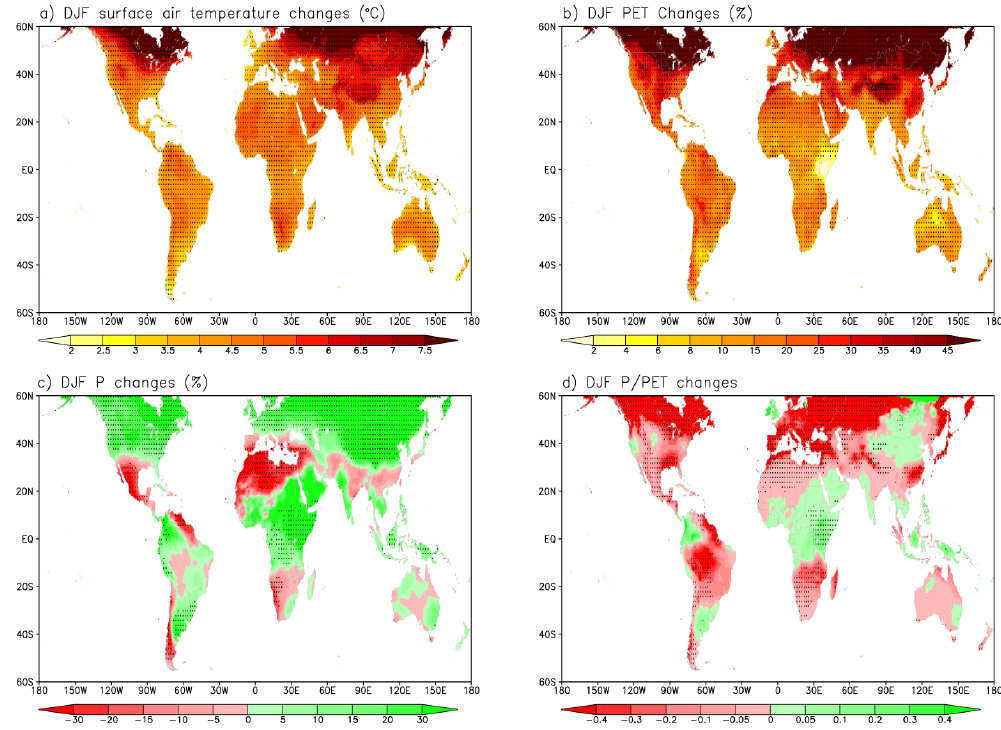
Fig. 11. Same as Fig. 7 but for the season of December–January–February.